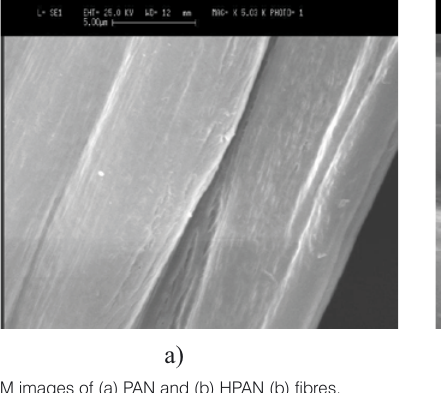
Figure 2. SEM images of (a) PAN and (b) HPAN (b) fibres.